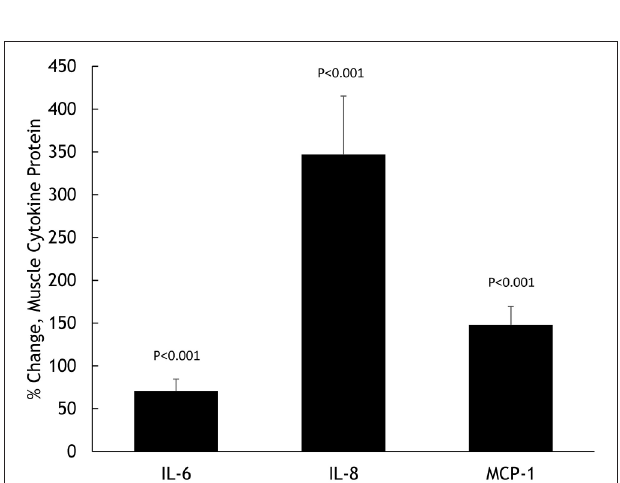
FIGURE 5 | Pre- and post-exercise plasma MCP-1